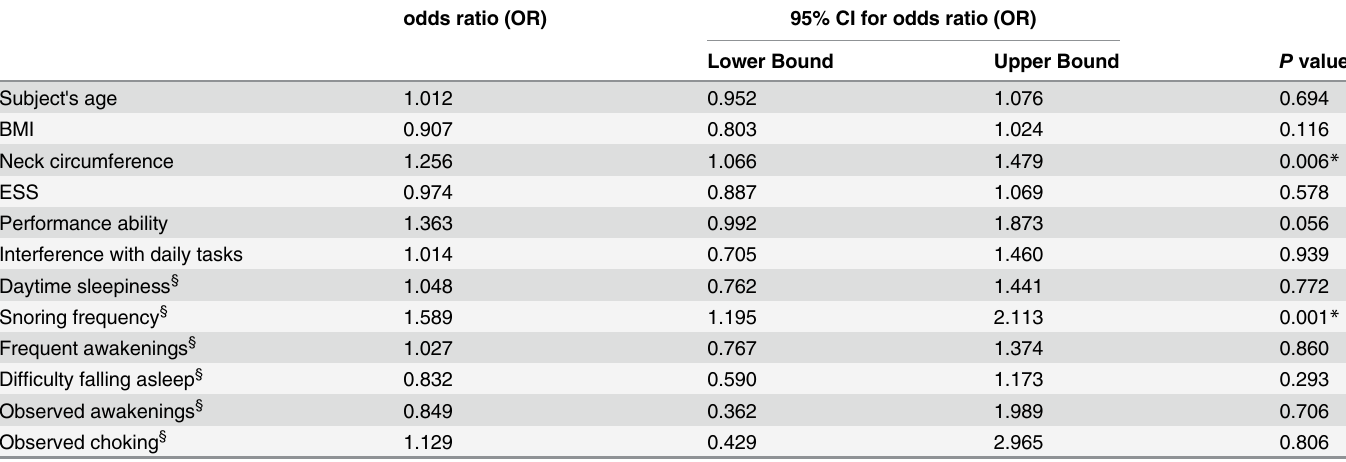
[5, 29, 30]. Although the prevalence of the disorder was found to be lower after the age of 70 yrs, 63.2% of the elderly population over 75 years suffered from the disease. Young et al [31] reported an increase in SDB prevalence with increasing 10-year age groups, with the association with an increase in the odds of having an AHI of 15 or greater by 24%. In our study, neck circumference and snoring frequency had a positive and independent associa- tion with AHI, whereas traditional risk factors, such as BMI, snoring intensity and ESS, were not after multiple regression analysis. The finding was consistent with previous studies.[31, 32] The ratio of men to women with OSAS in this study appears to be considerably higher than other community studies.[3, 29, 33] The reason of this discrepancy is not clear. Men with OSAS have a higher neck circumference than female patients although there was no significant difference when compared with non-OSAS subjects in each individual sex in our study. More- over, female OSAS patients tend to suffer from hypertension more than the male group. Sforza et al also compared women with and without OSAS and showed no significant differences in clinical or anthropometric measures[14]. The presence of hypertension was significantly asso- ciated with OSAS risk in women with the odds ratio of 1.52. All these data suggest that the oc- currence of OSAS is associated with hypertension in the elderly women. Table 6. Logistic regression analysis on the association between patients suffering from OSAS and several independent variables. odds ratio (OR) 95% CI for odds ratio (OR) Lower Bound P